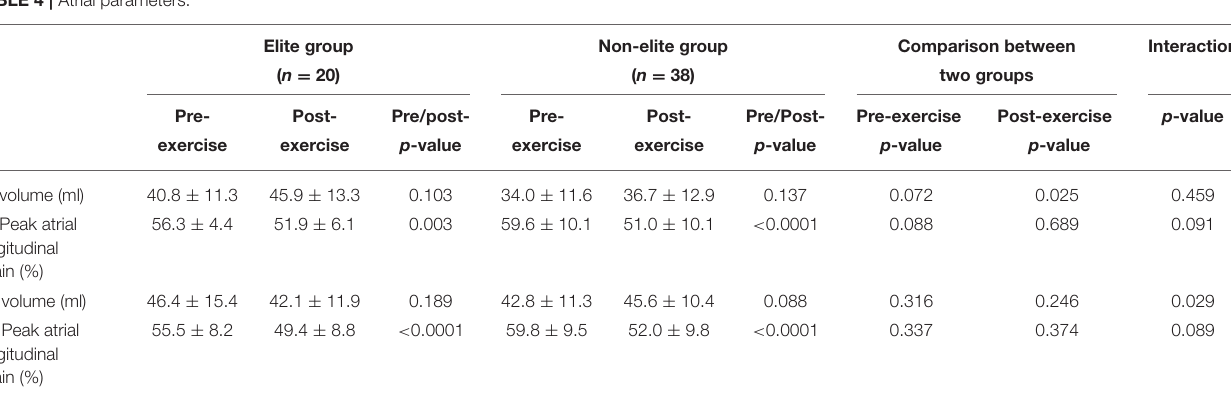
TABLE 4 | Atrial parameters. Elite group Non-elite group Comparison between Interaction